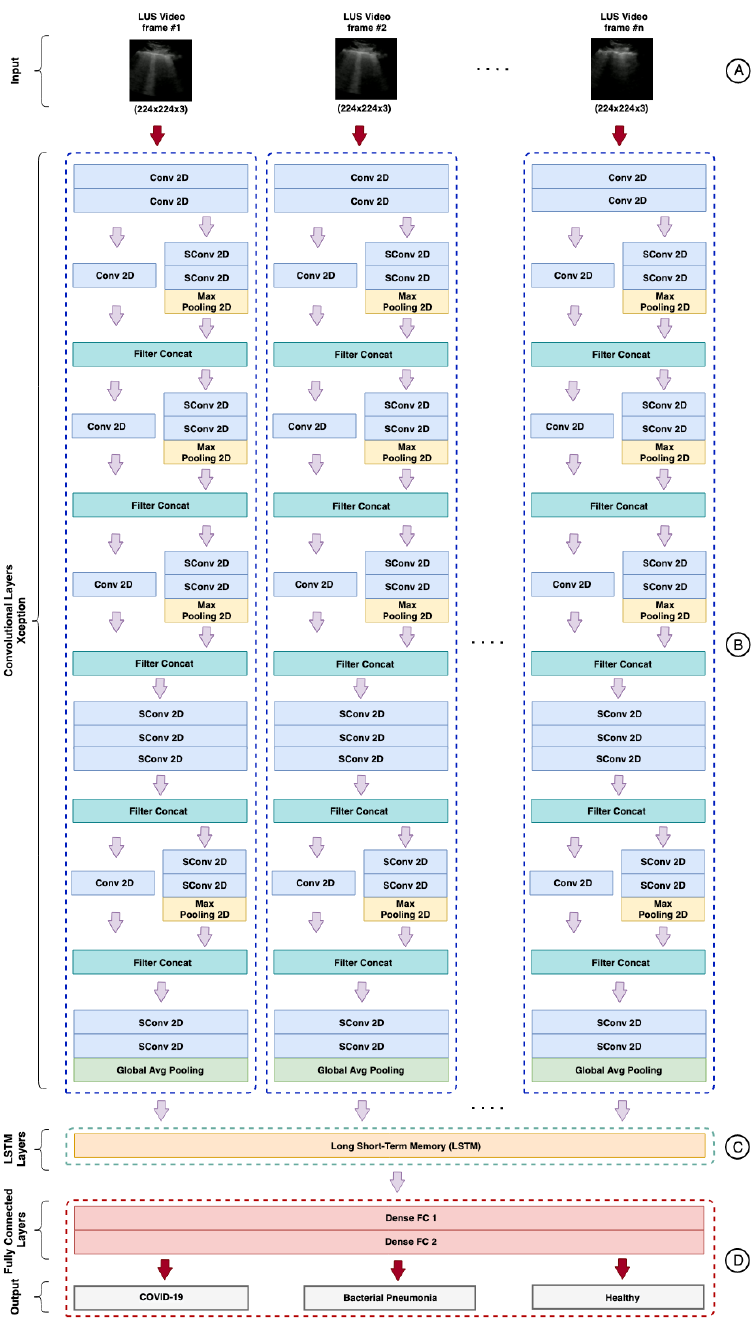
Figure A1. Hybrid model (Xception-LSTM): ( A ) represents the sequence of frames extracted from the videos. ( B ) represents the convolutional layers, the figure shows the convolutional base of an Xception. ( C ) represents the LSTM layer responsible for learning temporal features. ( D ) represents the classification